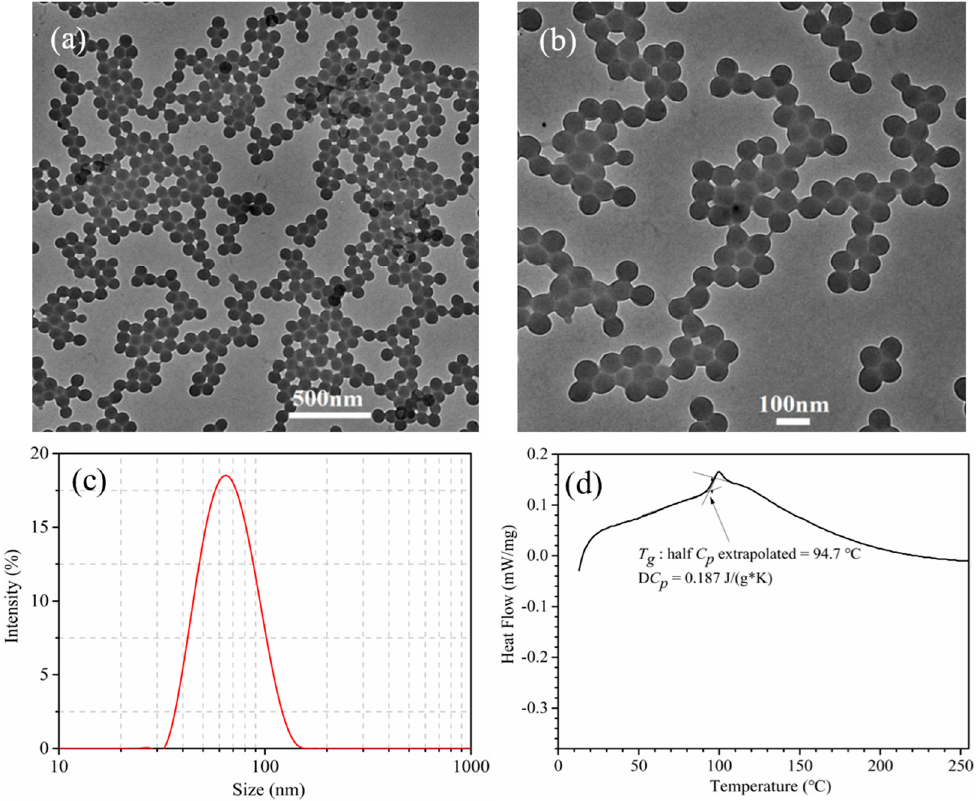
Figure 3. TEM images of P(St-BA-VBT) nanospheres with low magnifications ( a ), high magnifications ( b ), size distributions of P(St-BA-VBT) nanospheres ( c ), and differential scanning calorimetry (DSC) curve of P(St-BA-VBT) nanospheres ( d ).